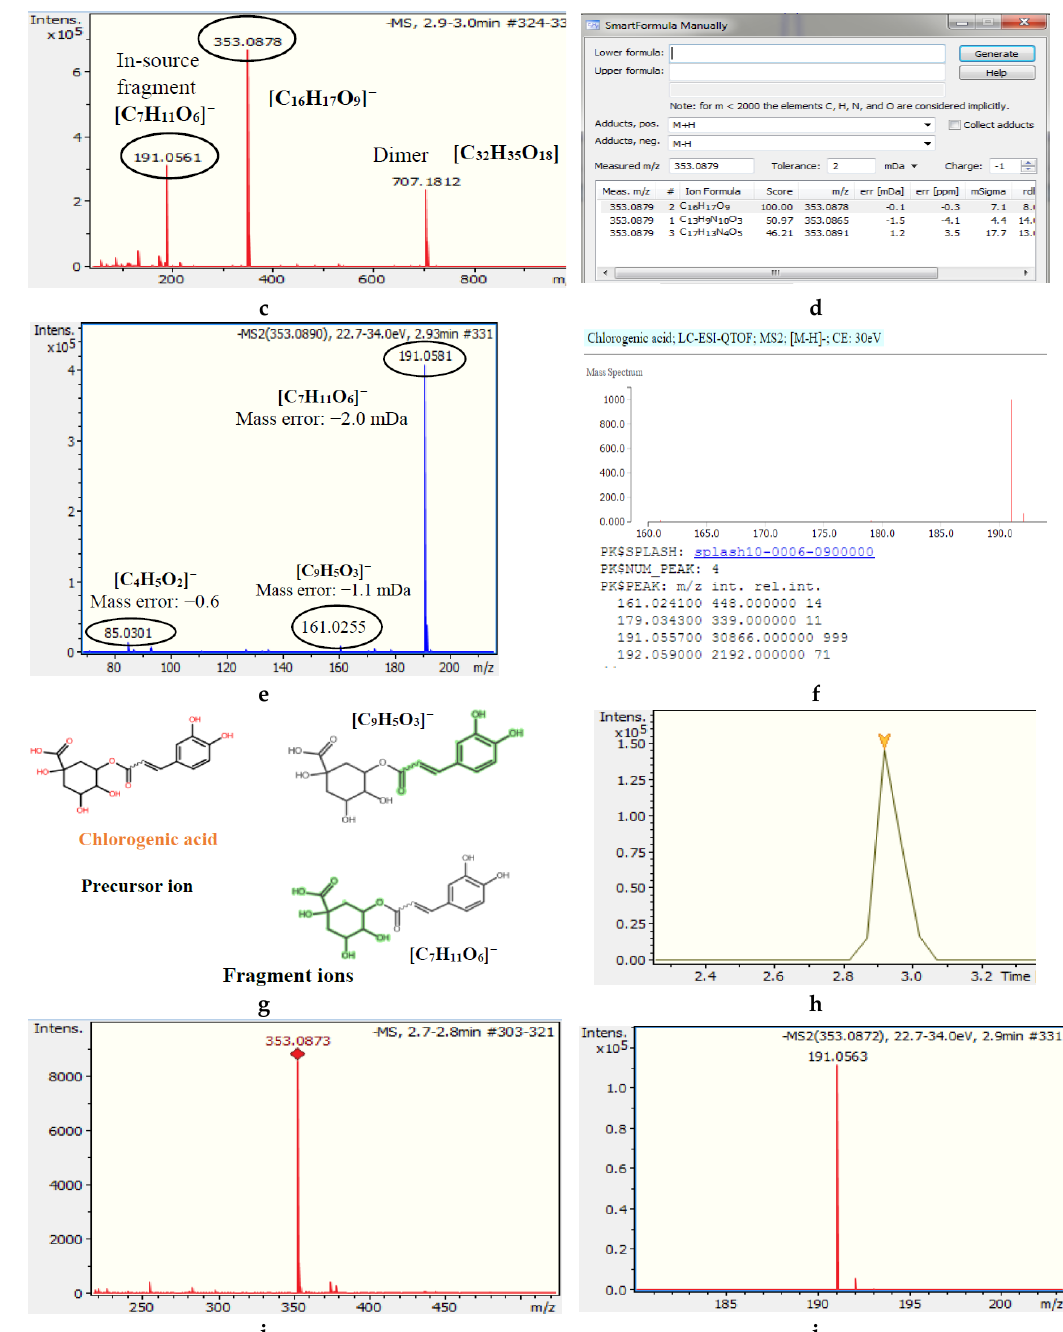
Figure 2. Identification data for the mass feature m/z 353.0878_2.9 min (chlorogenic acid). ( a ) EIC of m/z 353.0879 in apple – pomegranate juice. ( b ) EIC of m/z 353.0879 in authentic and adulterated pomegranate juice. ( c ) MS spectra of mass feature m/z 353.0879_2.9 min. ( d ) Probable elemental composition of mass feature m/z 353.0879_2.9 min. ( e ) MS/MS spectra of mass feature m/z 353.0879_2.9 min. ( f ) MS/MS spectra of chlorogenic acid (MassBank record FIO00625). ( g ) Precursor and fragment ions of chlorogenic acid. ( h ) EIC of m/z 353.0879 in the chlorogenic acid reference standard. ( i ) MS spectra of chlorogenic acid. ( j ) MS/MS spectra of chlorogenic acid.